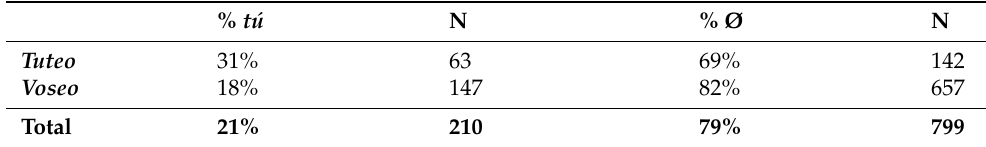
Table 4. Rates of subject expression ( t ú vs. Ø) for tuteo vs. voseo. % t ú N % Ø N Tuteo 31% 63 69% 142 Voseo 18% 147 82% 657 Total 21% 210 79%